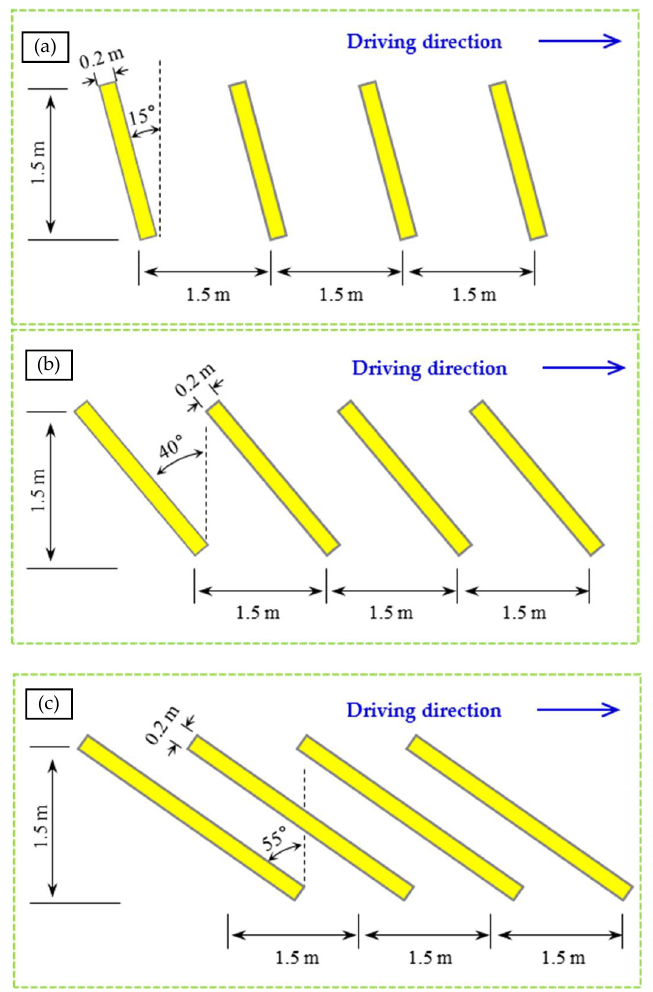
Figure 3. Schematics of slash-line VIDD: ( a ) 15°; ( b ) 40°; ( c ) 55°.